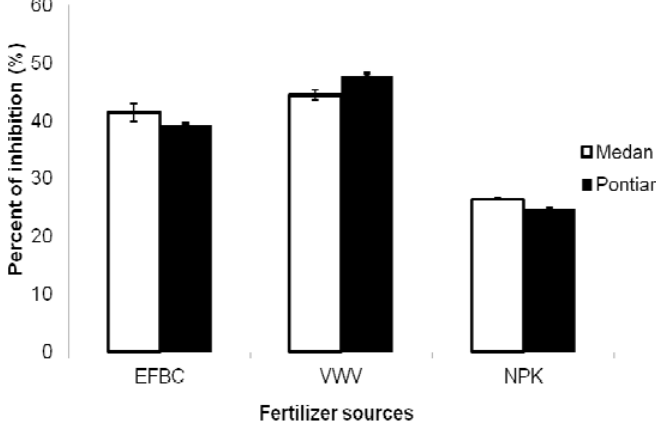
Figure 2. DPPH scavenging activities of cassava varieties treated with different fertilizer